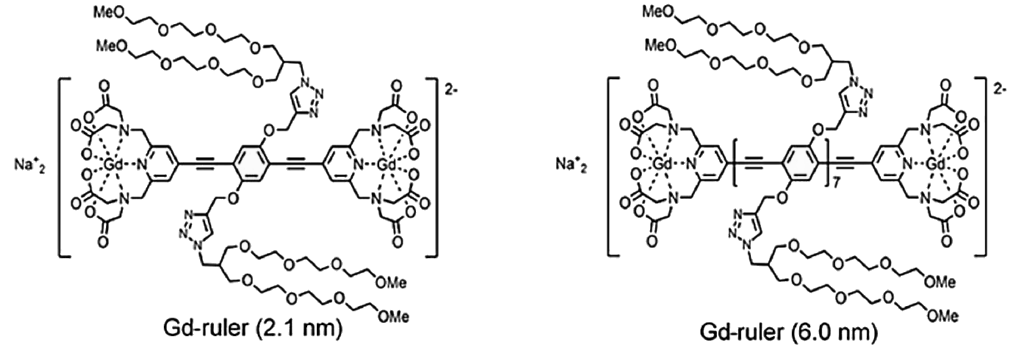
Figure 1. Chemical structures of Gd-ruler systems used in the current